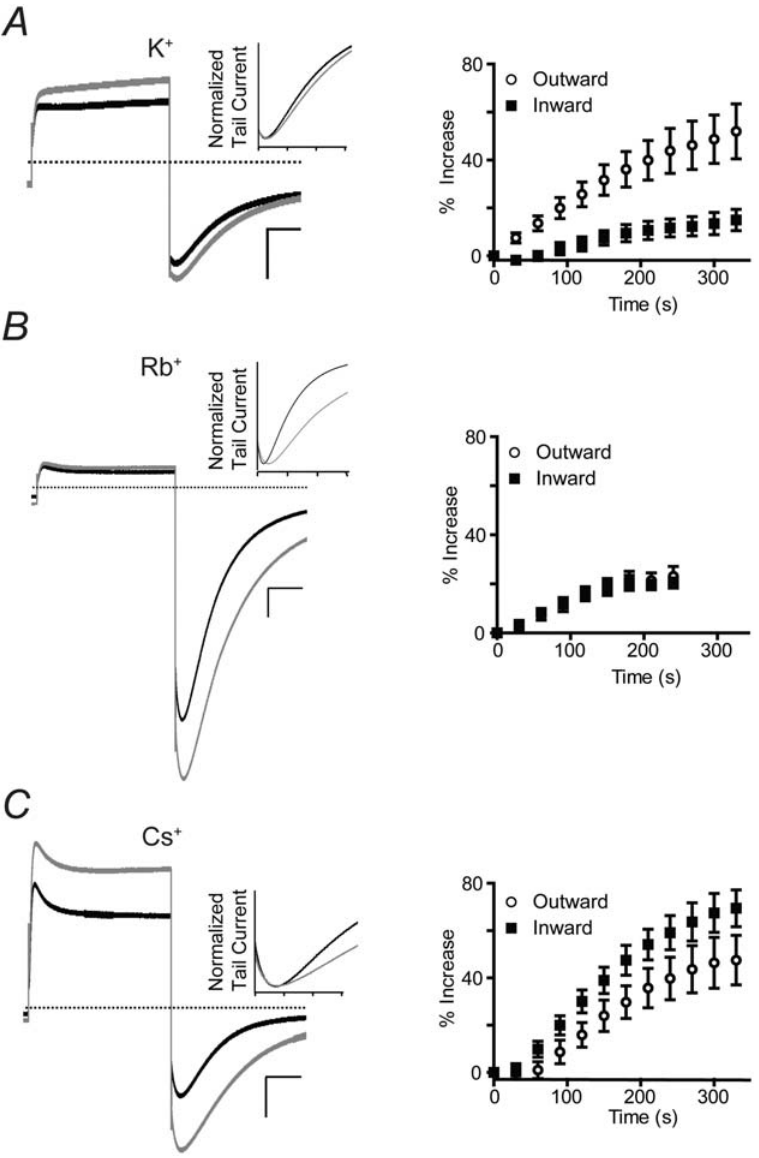
Figure 5. Activation of Q1 by PBA is dependent on the external charge carrier ion. Current traces were recorded in (A) 50 mM K + , (B) Rb + , or (C) Cs + . Left panel: Representative overlaid traces elicited by a + 40 mV test and 2 80 mV tail pulse before and after the onset of PBA potentiation. Inset: Normalized tail currents comparing the deactivation kinetics before and after the onset of PBA potentiation. Tick marks represent 200 ms. Right panel: Time course of current recorded during the PBA potentiation phase. Outward current measured at the end of a 2 s pulse to + 40 mV; maximal inward current measured during the 2 80 mV tail pulse. Time zero is the amount of current after initial inhibition but before potentiation by PBA. Data are represented as the mean 6 SEM